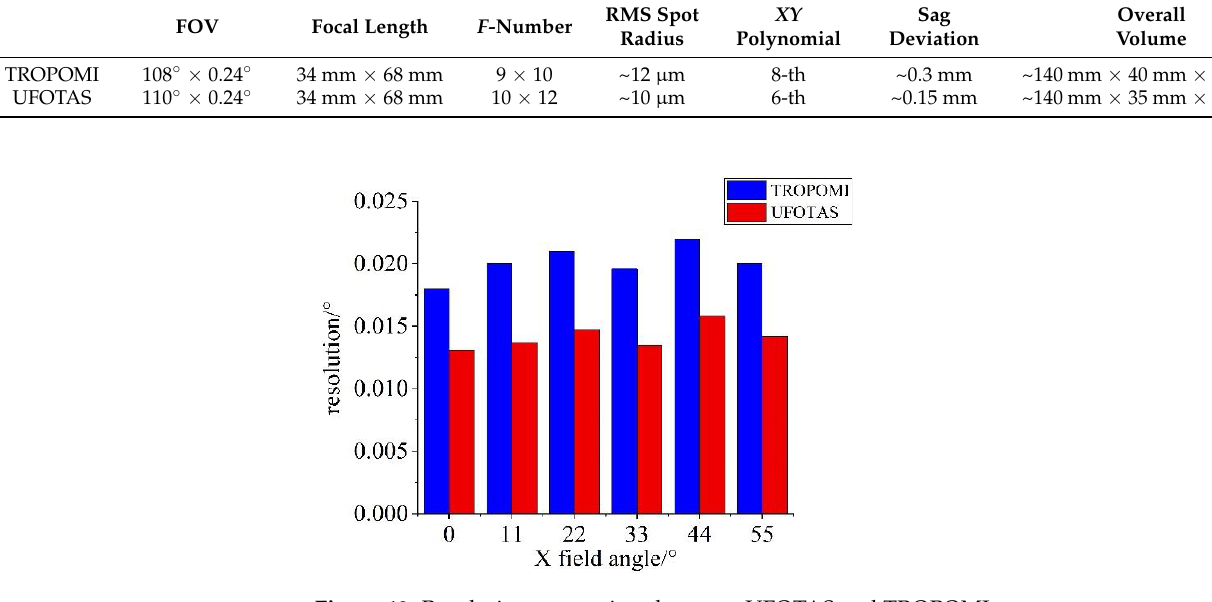
Figure 12. Resolution comparison between UFOTAS and